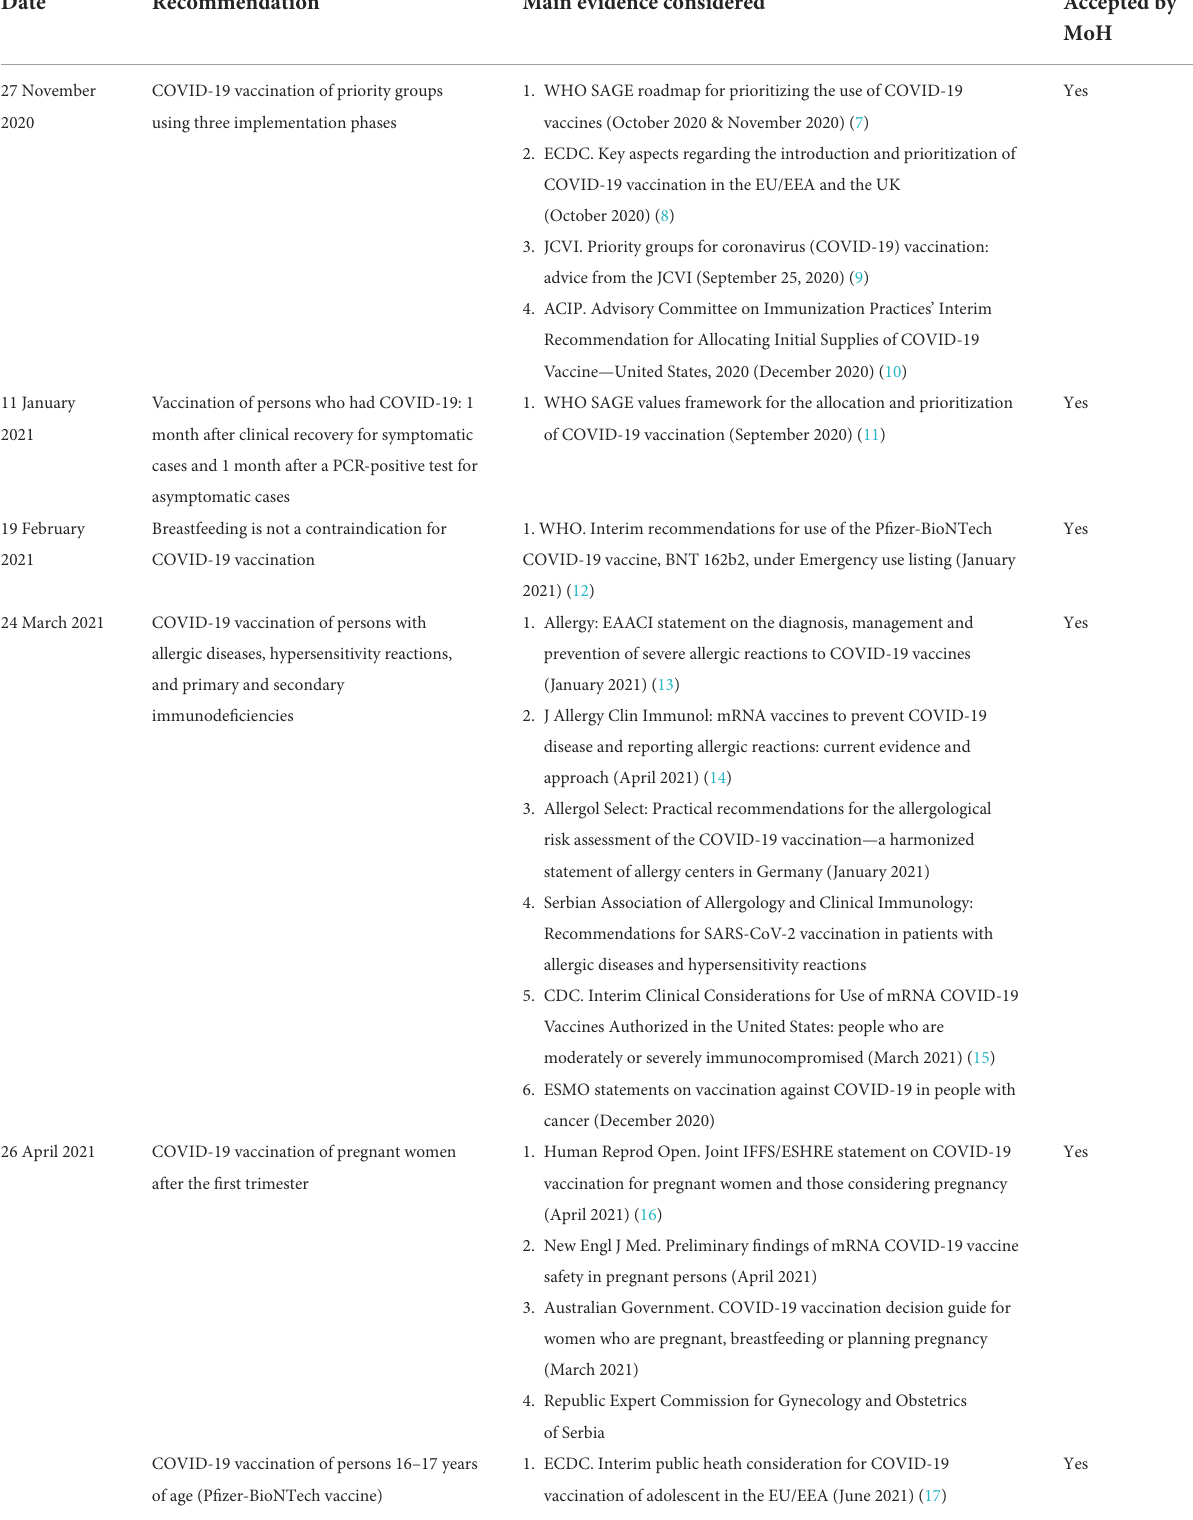
TABLE 1 Key COVID-19 vaccine recommendations developed by the Serbian Expert Committee on